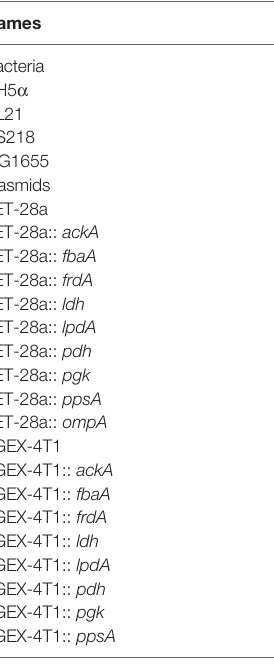
TABLE 1 | Bacterial strains and plasmids used in this